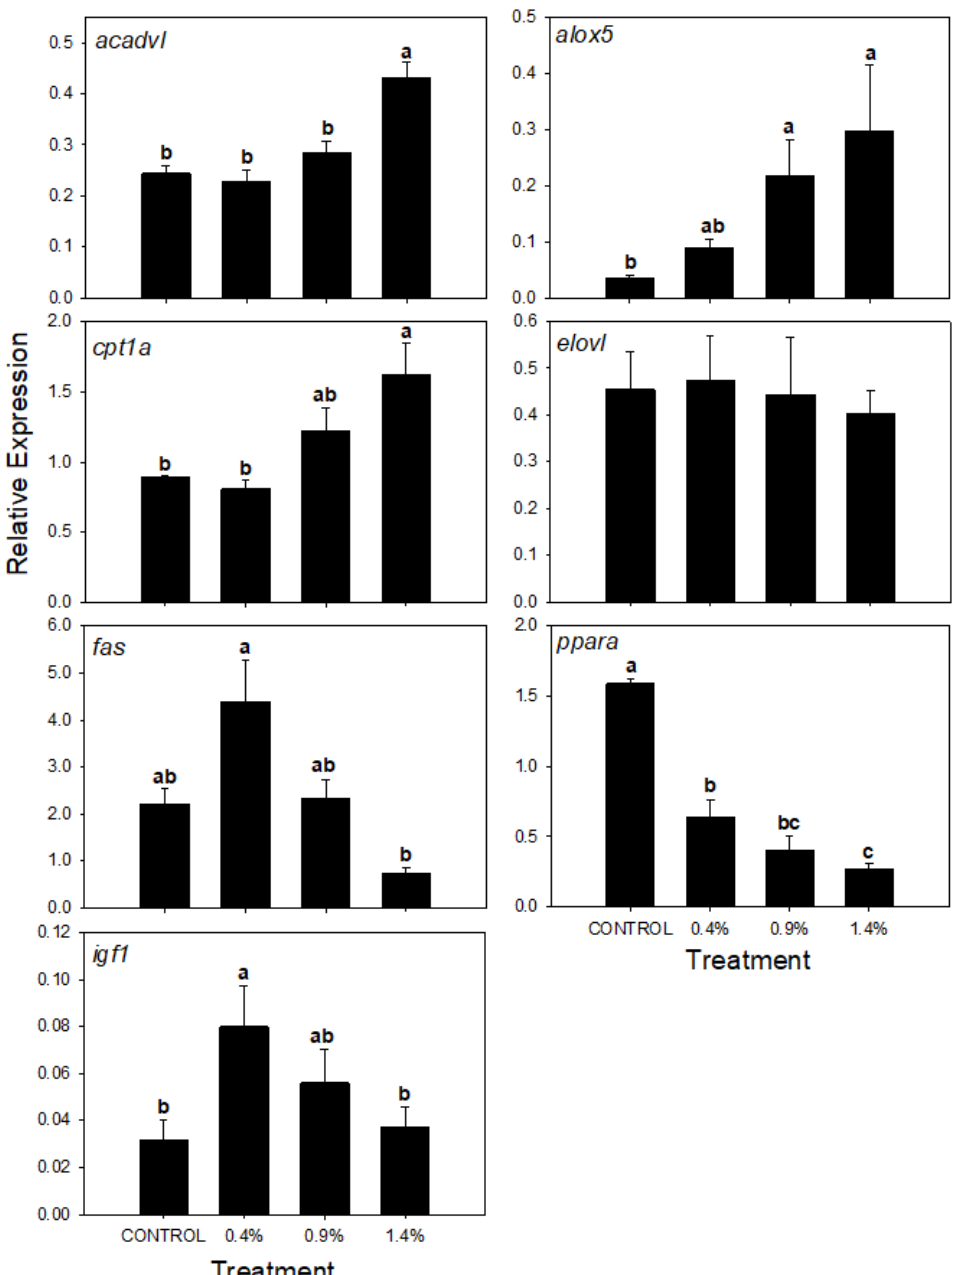
Figure 1. acyl-CoA dehydrogenase very long chain ( acadvl ), arachidonate 5-lipoxygenase ( alox ), carnitine O-palmitoyltransferase 1 ( cpt1a ), fatty acid elongase 5 ( elovl ), fatty acid synthase ( fas ), proliferator activated receptor alpha ( ppara ) and insulin-like growth factor ( igf ) relative expression in S. dorsalis liver, fed with the different experimental diets. Different letters represent significantly different values ( p < 0.05) within the same treatment ( n = 6).